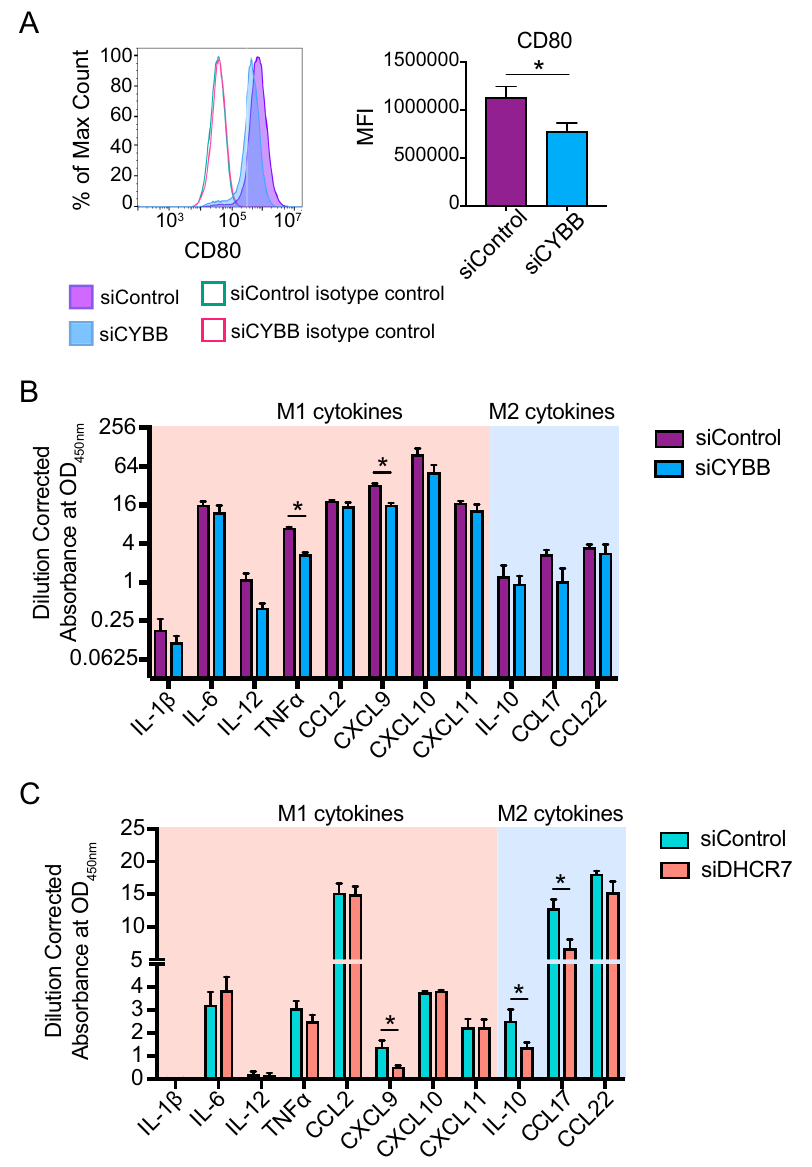
Fig 5. CYBB and DHCR7 regulate M1 and M2 macrophages. (A) Differential surface CD80 expression of M1 macrophages exposed to either siControl or siCYBB. MFI indicates mean fluorescence intensity. Differential cytokine secretion profile of (B) M1 macrophages exposed to siControl or siCYBB (C) M2 macrophages exposed to siControl or siDHCR7. Canonical M1 and M2 cytokines are highlighted in the pink and blue background, respectively. � p < 0.05 and error bars represent SEM of at least 3 biological